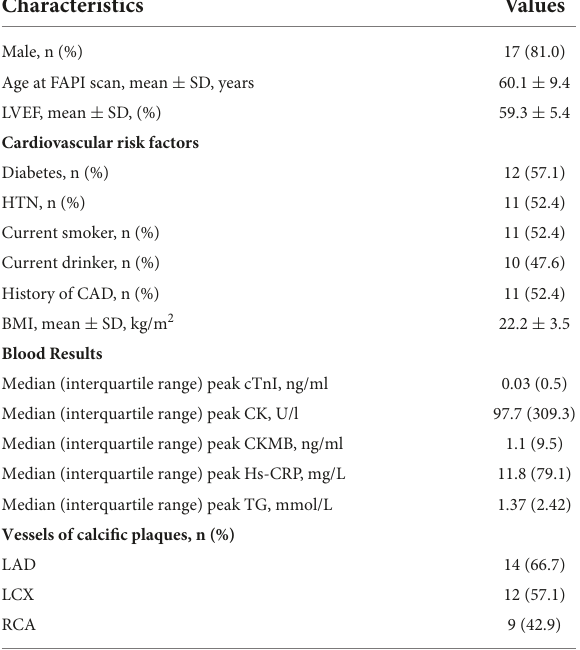
TABLE 1 Patient characteristics ( n = 21 patients).